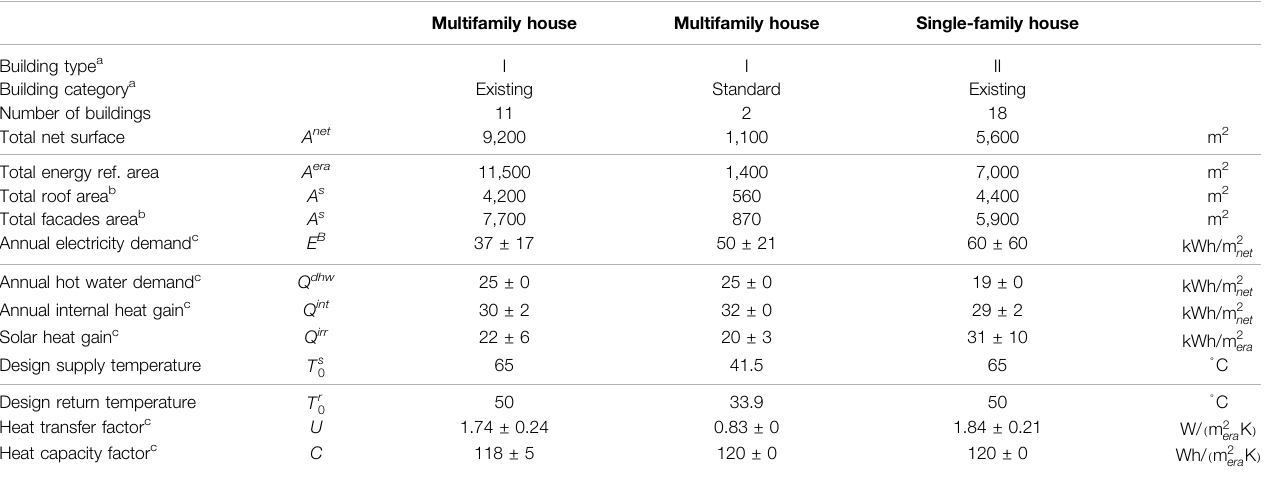
TABLE 3 | Input data for 31 buildings. All buildings are connected to the same low-voltage grid. Multifamily house Multifamily